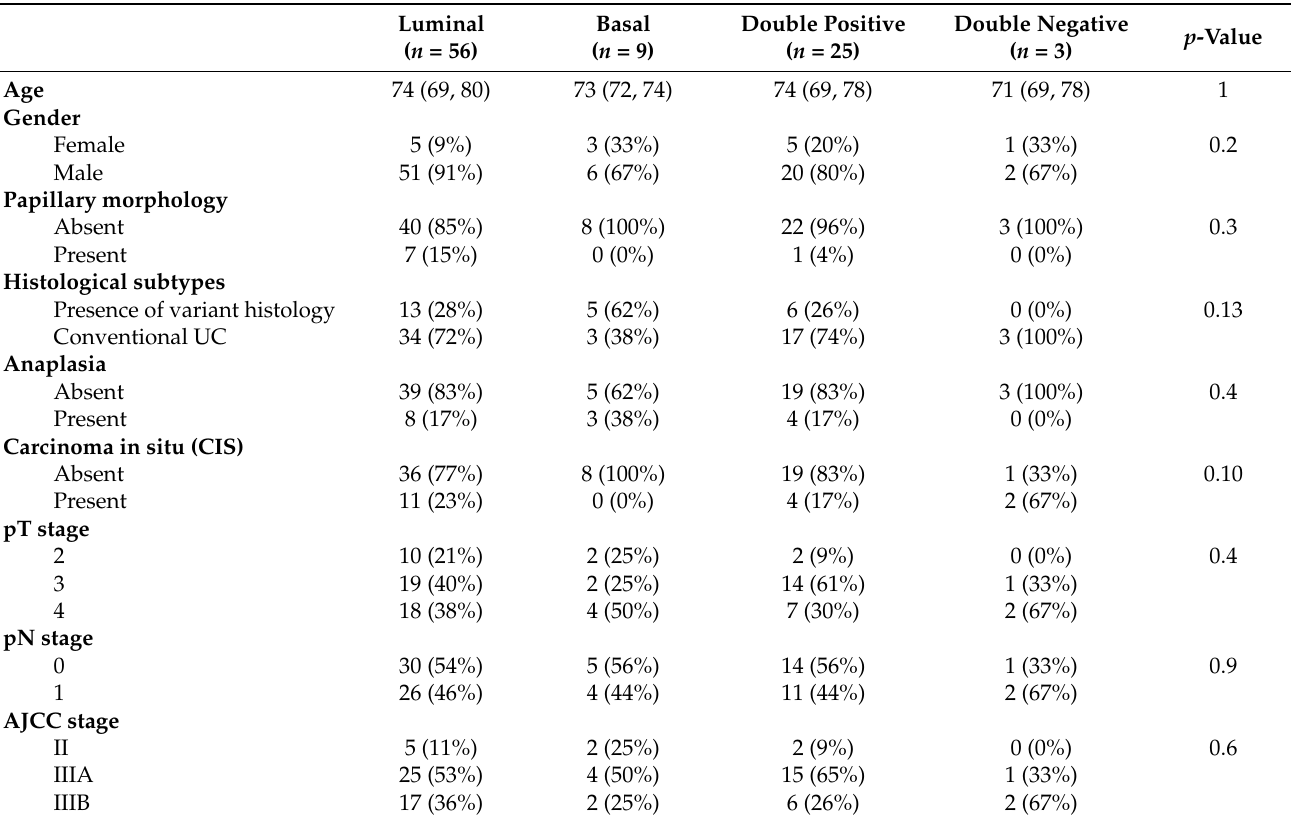
Table 4. Association between molecular subtypes obtained through Scheme #2 and clinicopathological variables. p -value < 0.05 are highlighted in